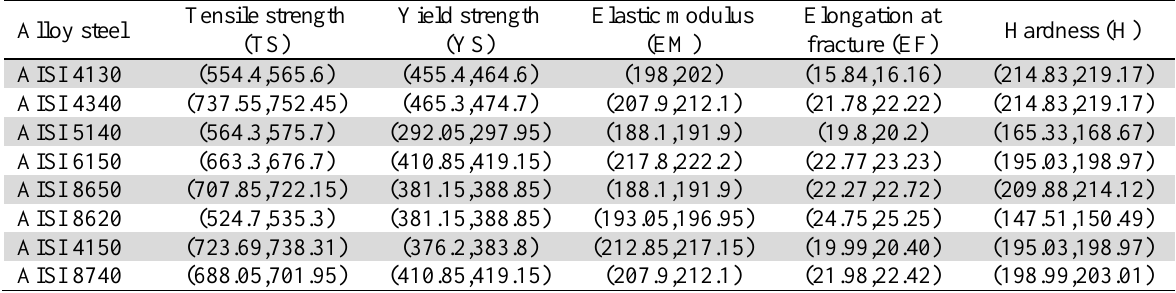
Grey decision matrix for alloy steels Alloy